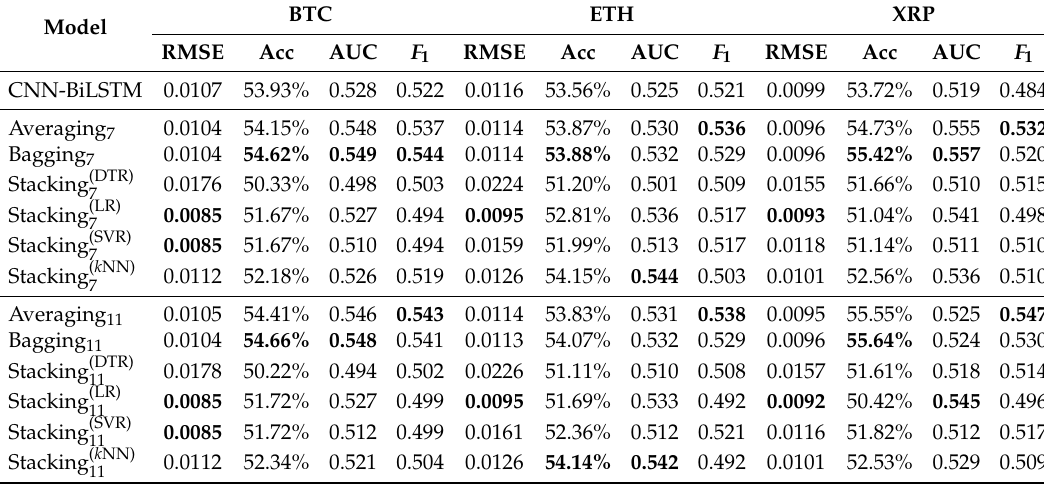
Table 5. Performance of ensemble models using CNN and bi-directional LSTM (CNN-BiLSTM) as base learner for m =